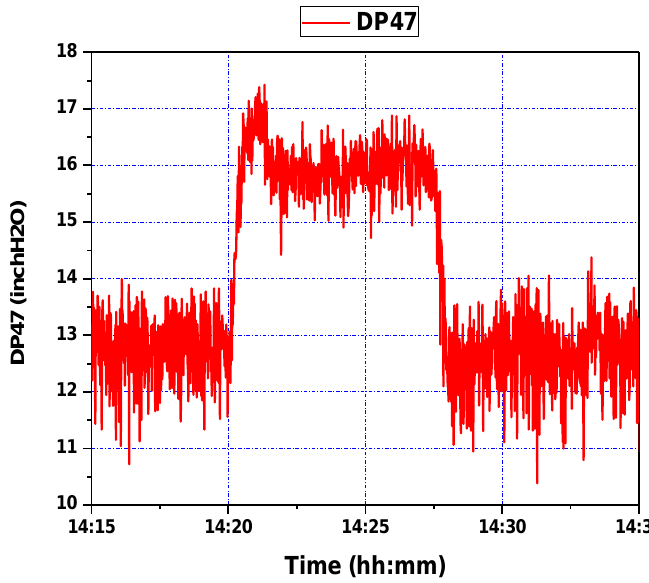
Energies 2020 , 13 , x FOR PEER REVIEW Figure 9. Pressure di ff erence response of riser (DP47) during step setpoint changes. Figure 9. Pressure difference response of riser (DP47) during step setpoint changes.